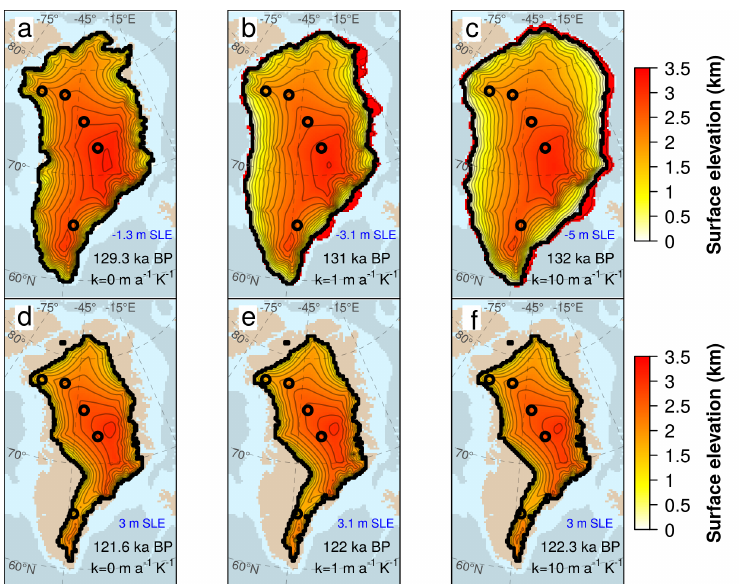
Figure 6. GrIS surface elevation (km) simulated at the penultimate glacial maximum (TII) (a–c) and at the LIG minimum (Eemian) (d–f) for three values of the melting rate sensitivity κ having set B ref = 1ma − 1 . The timing of these snapshots depends on the experiment and is stated in black for each snapshot. Corresponding ice volume (in s.l.e.) is shown in blue. Red zones represent the ice shelves extending beyond the glacial maximum grounding line (black line). Black circles indicate the locations of the Camp Century, NEEM, NGRIP, GRIP and Dye3 ice cores (from north to south).